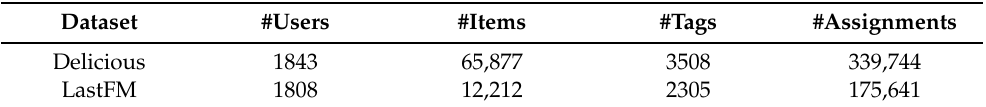
Table 1. Statistics of the two